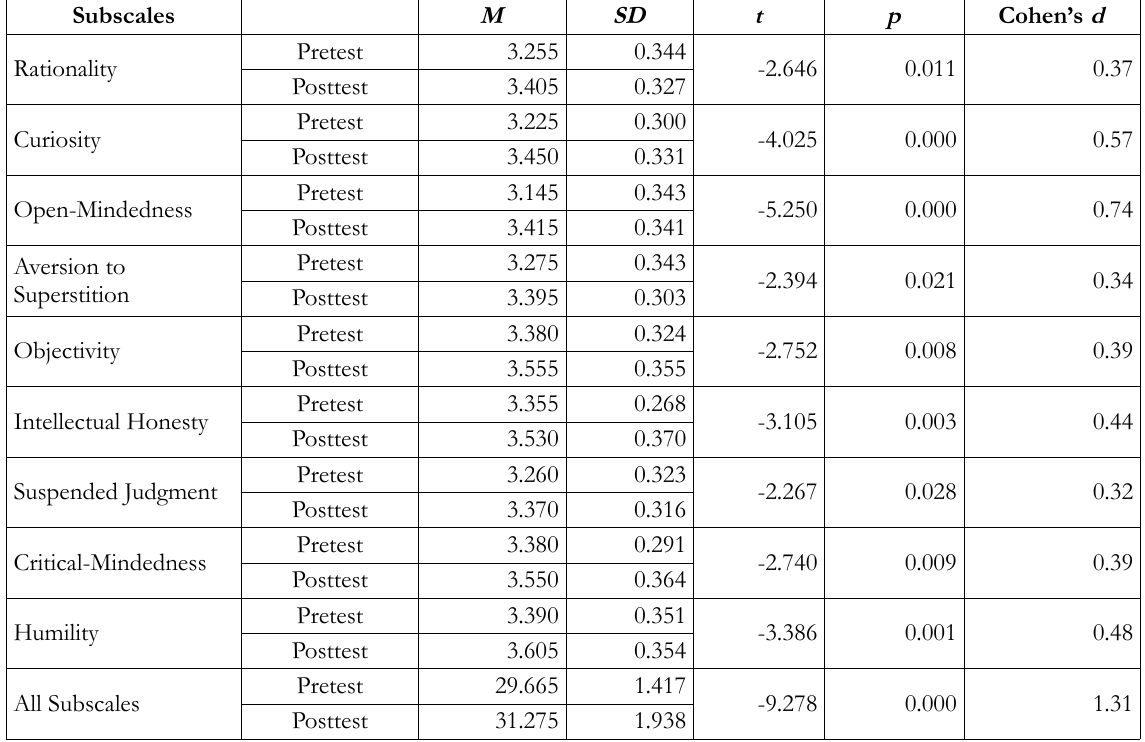
Table 2. Differences Between Pretest and Posttest Scores on Scientific